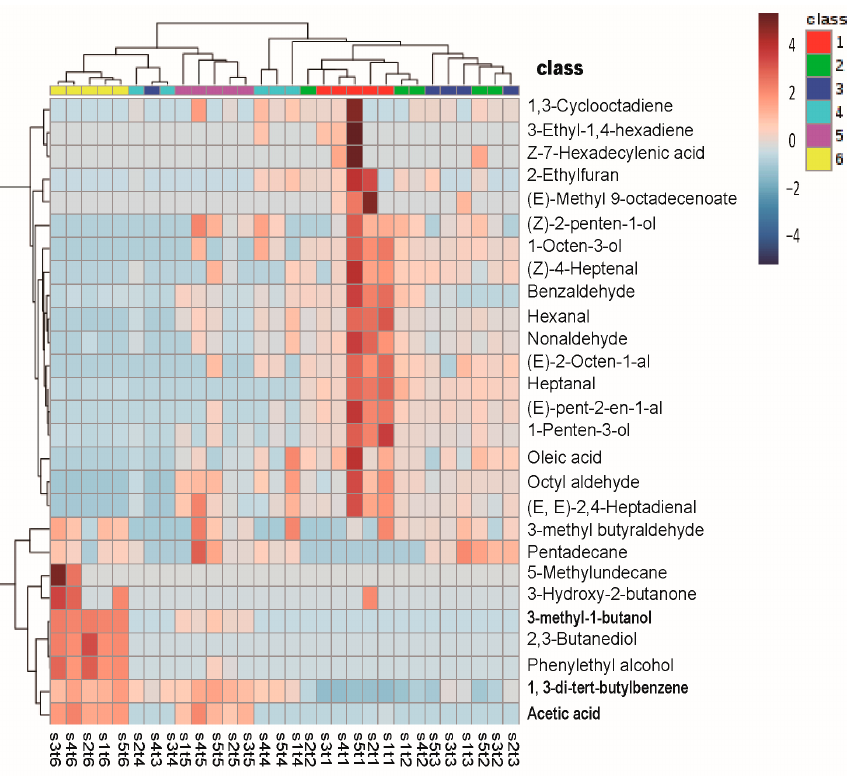
Figure 3. Clustering result shown as heatmap. Storage time at 4 °C: class 1 represents 0 day, class 2 represents 4 day, class 3 represents 8 day, class 4 represents 12 day, class 5 represents 18 day, and class 6 represents 20 day. Each experimental group is set with five parallels. The x-axis is expressed in the form of SaTb, where “a” represents the parallel value and “b” represents the class of different storage days. The most and least intense relative abundance values are depicted in red and blue, respectively.